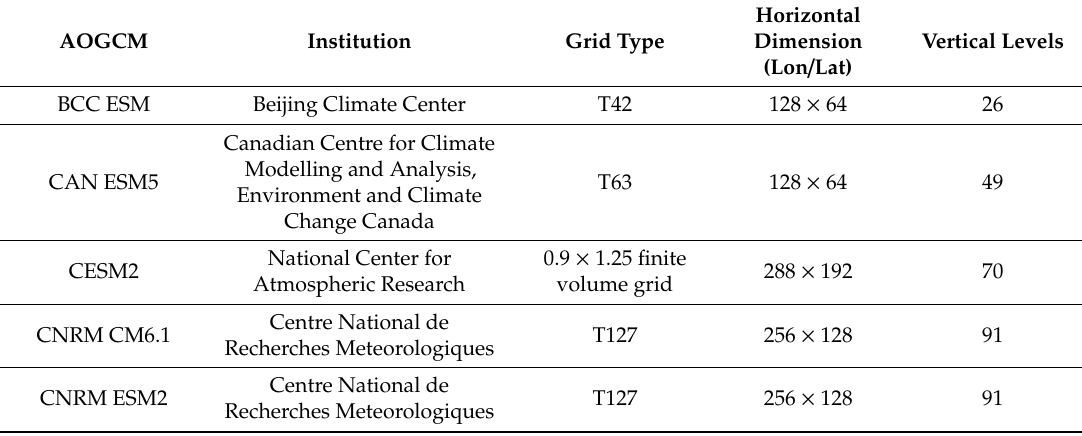
Figure 1. Study domain over the Tsa Tue Bio-reserve, located in Northwest Territories, Canada. In the inset, the location is shown in the box in the perspective of the entire Canada. The basemap is downloaded from ESRI © using opensource python package. Table 1. Features of di ff erent input atmosphere–ocean global climate models